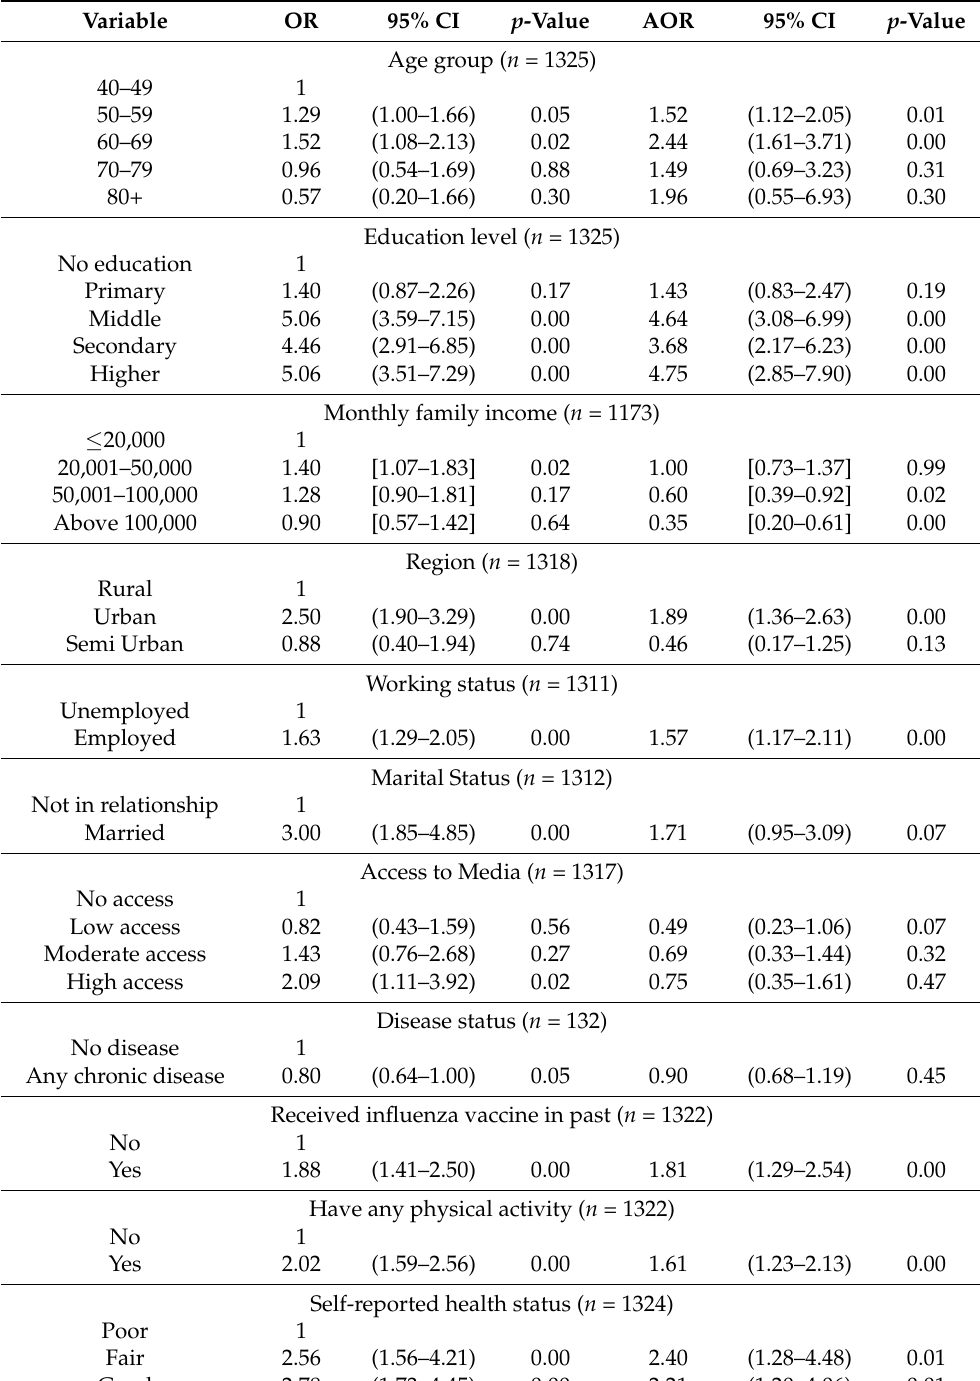
Table 9. Bivariate and multivariable logistic regression for factors associated with vaccination status of respondents (n =